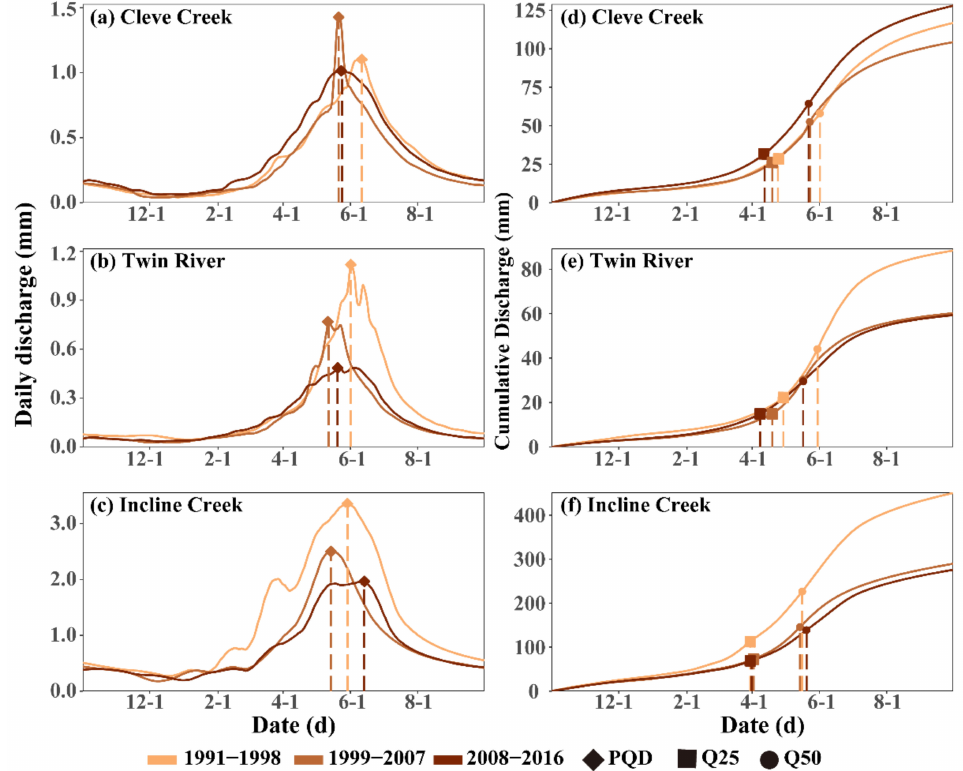
Figure 2. The occurrence of Q25 and Q50 and the peak discharge in three watersheds. ( a – c ) for PQ in Cleve Creek, Twin River and Incline Creek, and ( d – f ) for Q25 and Q50 in t in Cleve Creek, Twin River and Incline